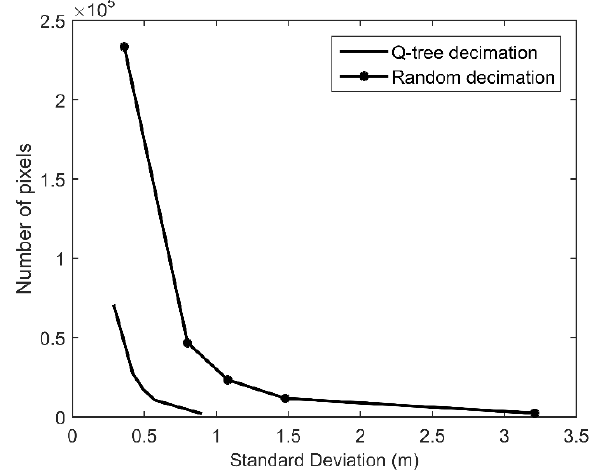
Figure 3. Experimental relationship between the number of pixels used to represent DTMs vs. the standard deviation of the mean elevation difference between the decimated and reference